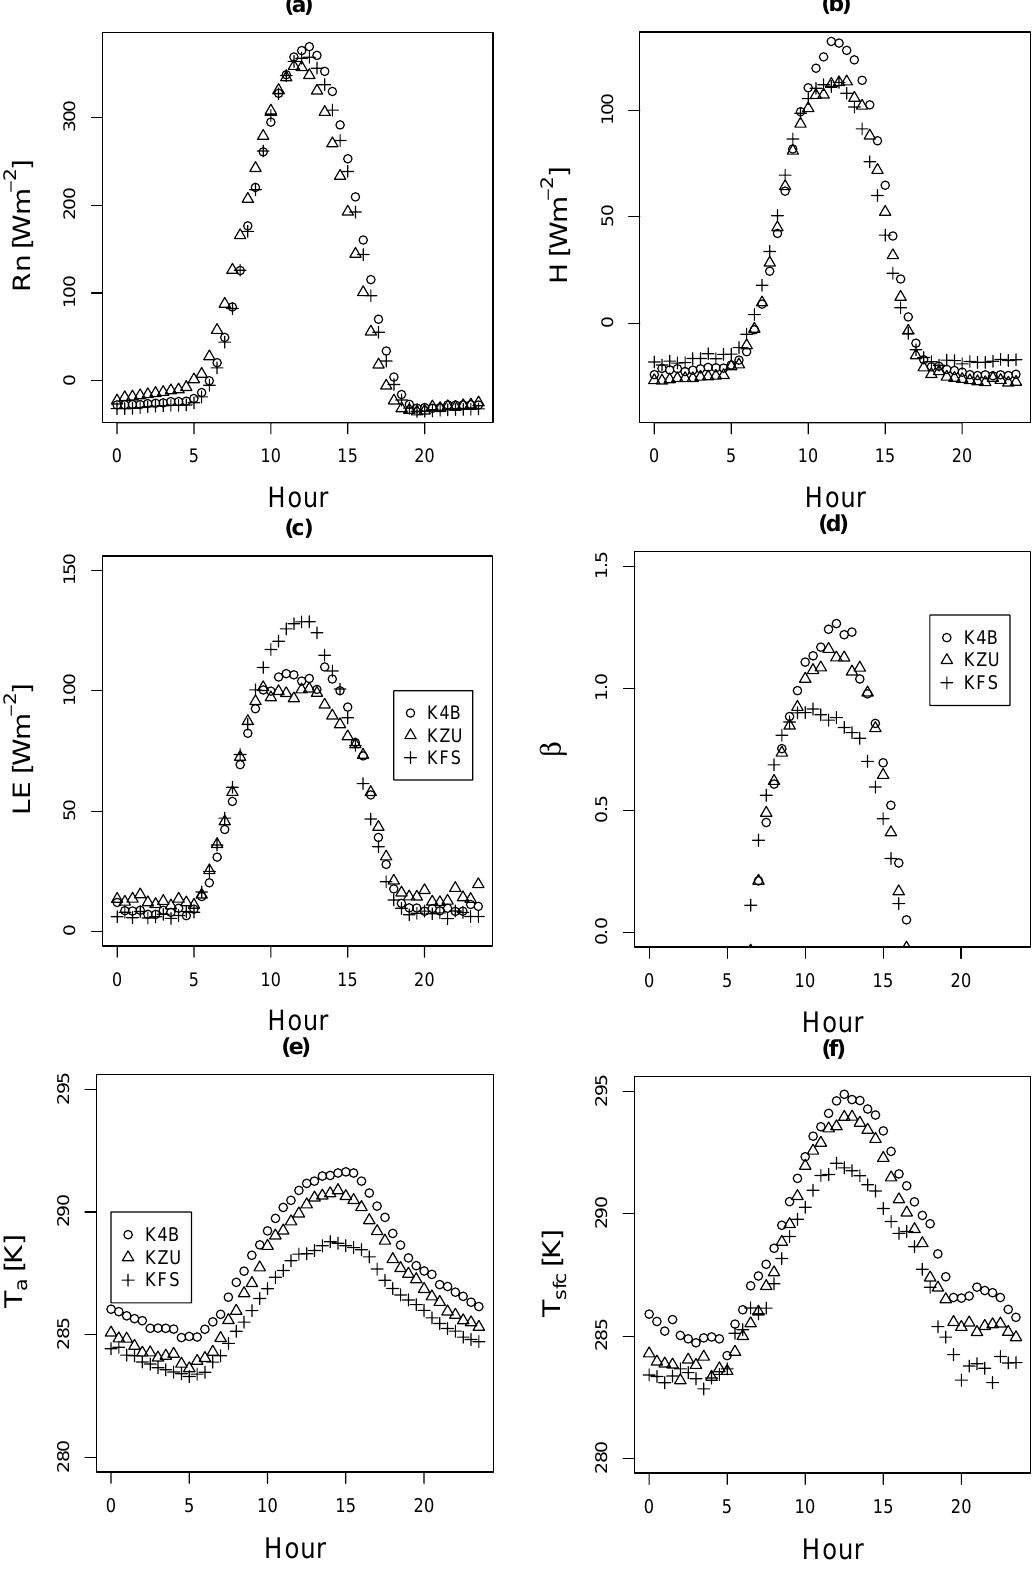
Fig. 9. Mean diurnal variability of (a) net radiation (b) sensible heat flux (c) latent heat flux (d) Bowen ratio ( β = H /LE) (e) air temperature and (f) the surface temperature from the eddy covariance data at each of the field